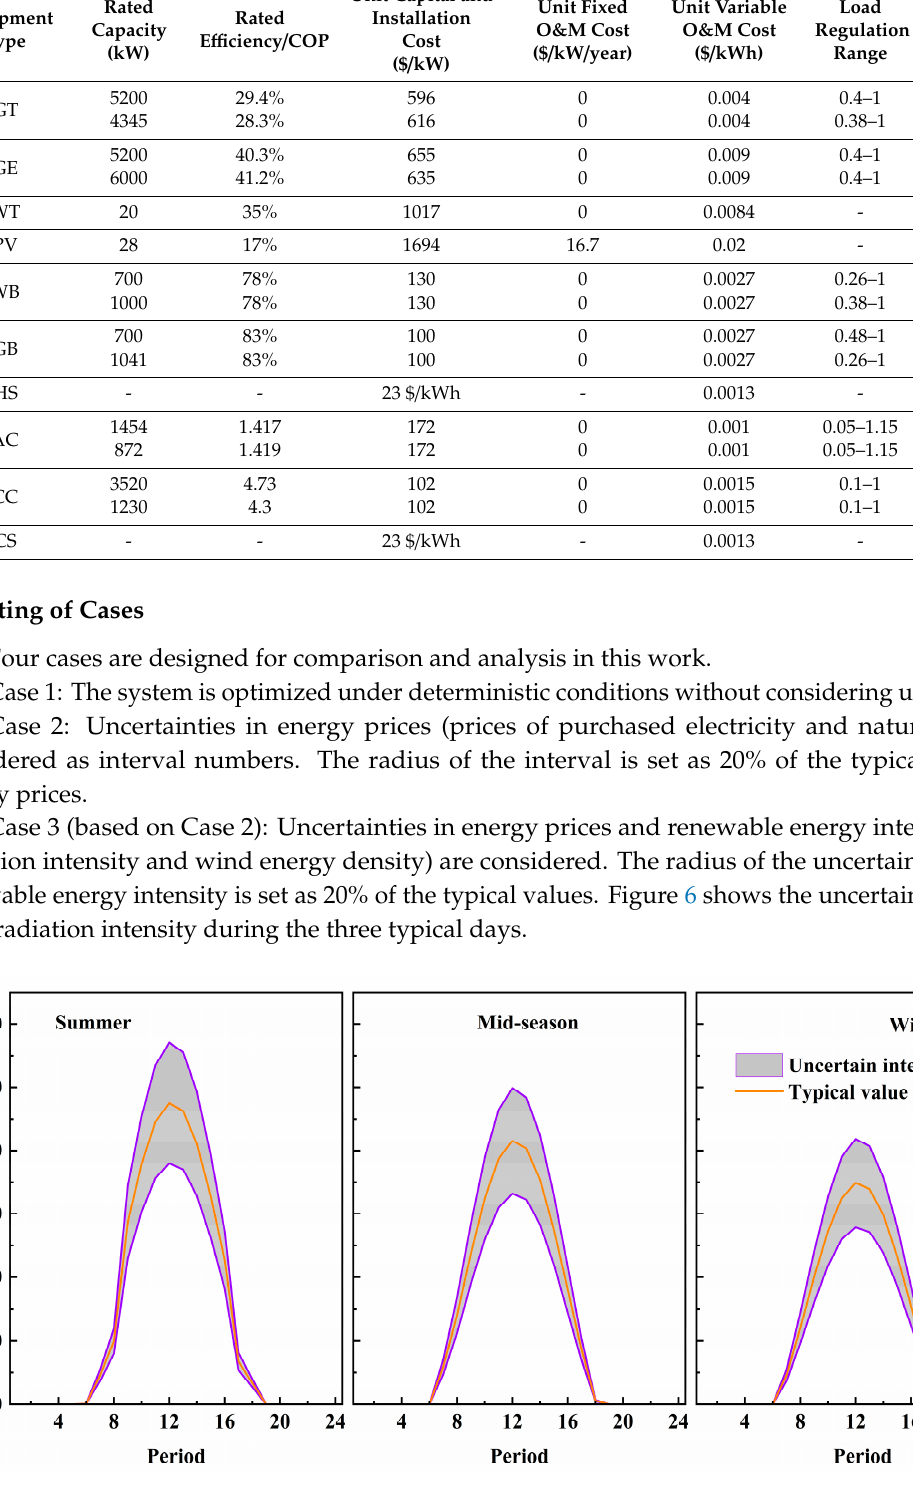
Figure 6. Uncertain intervals of solar radiation intensity during the three typical